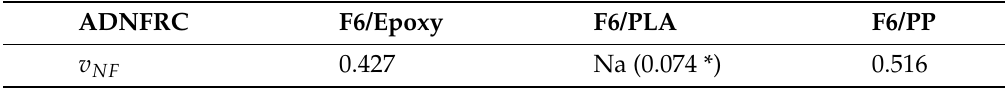
Table 4. Fibre volume fraction, v NF , of 6 mm flax-ft (F6) in the